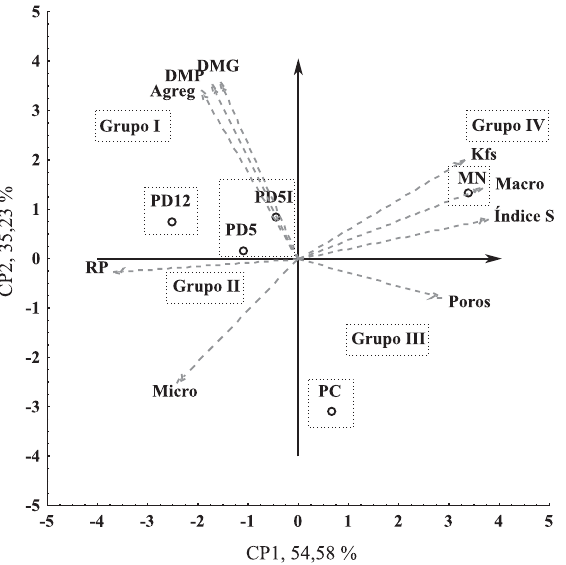
Figura 4. Dispersão (gráfico biplot ) produzida por análise de componentes principais na profundi- dade 0–0,20 m das propriedades físicas do Latossolo Vermelho acriférrico típico (LVwf) submetidos a diferentes usos e manejos (PD12, PD5, PD5I, PC e MN): agreg = agregados com